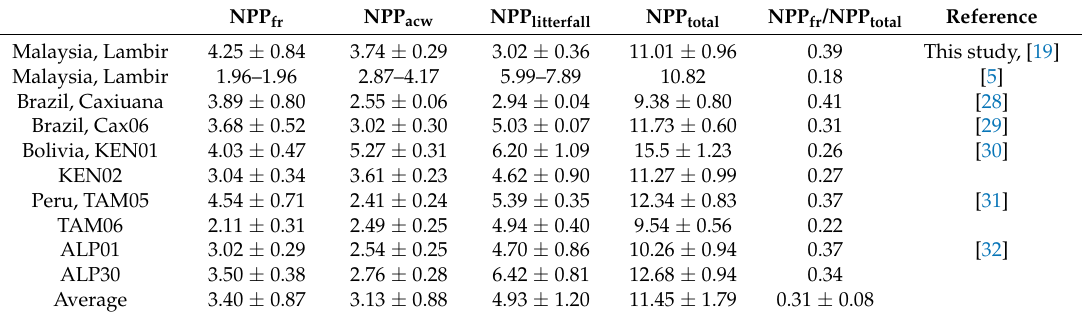
Table 1. Each component of NPP (mean ± standard error, MgC ha − 1 year − 1 ) and the fraction of NPP fr to NPP total . NPP fr NPP acw NPP litterfall NPP total NPP fr /NPP